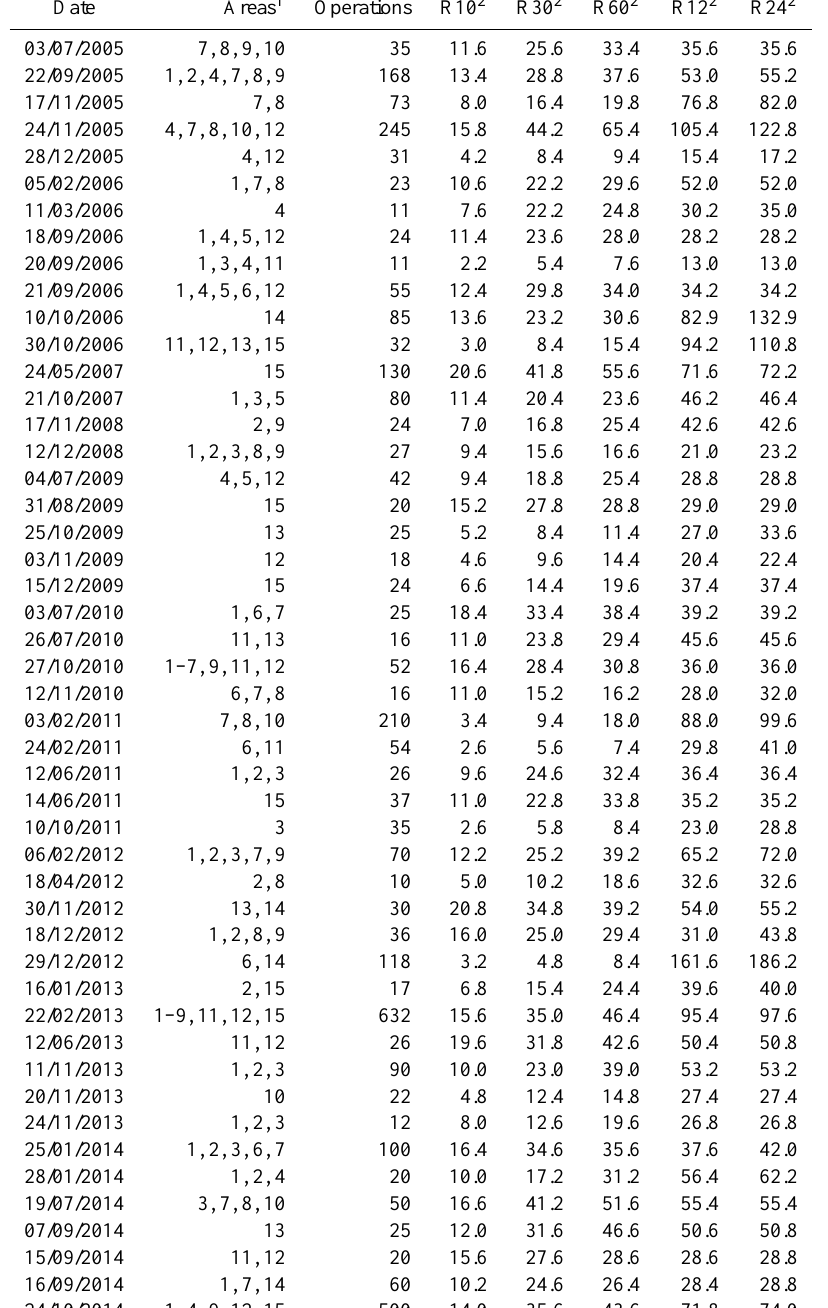
Table 1. Areas affected, number of fire service operations and rainfall (in mm, at various accumulation durations) per flash flood